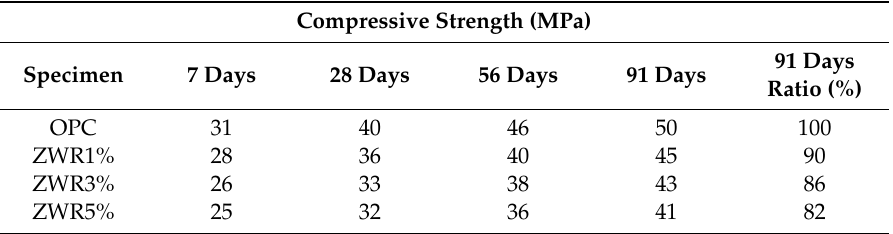
Table 9. Result of compressive strength test.